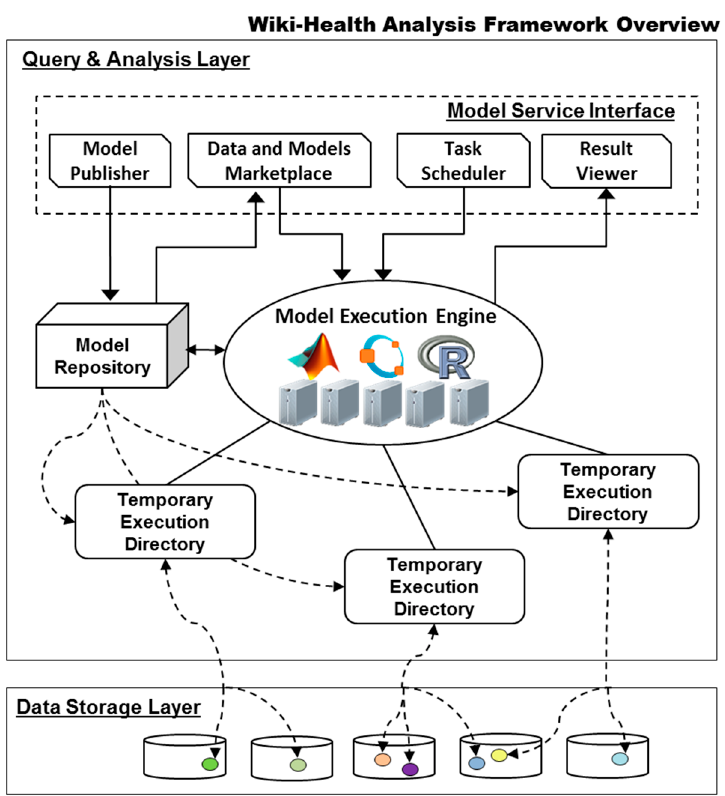
Figure 2. The architecture of Wiki-Health analysis framework.